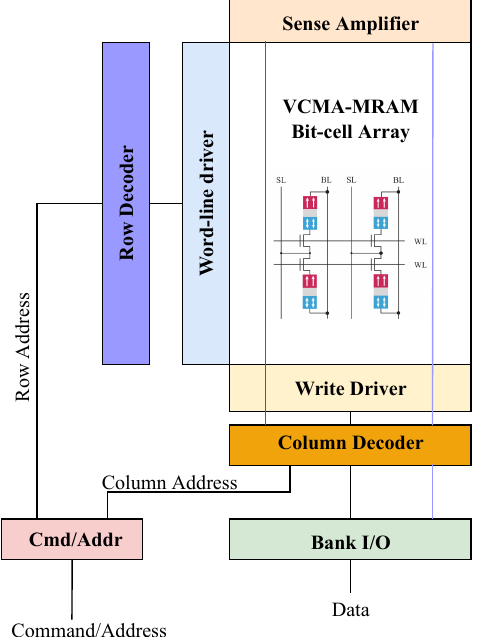
Figure 2. Schematic diagram of VCMA-MRAM bank.